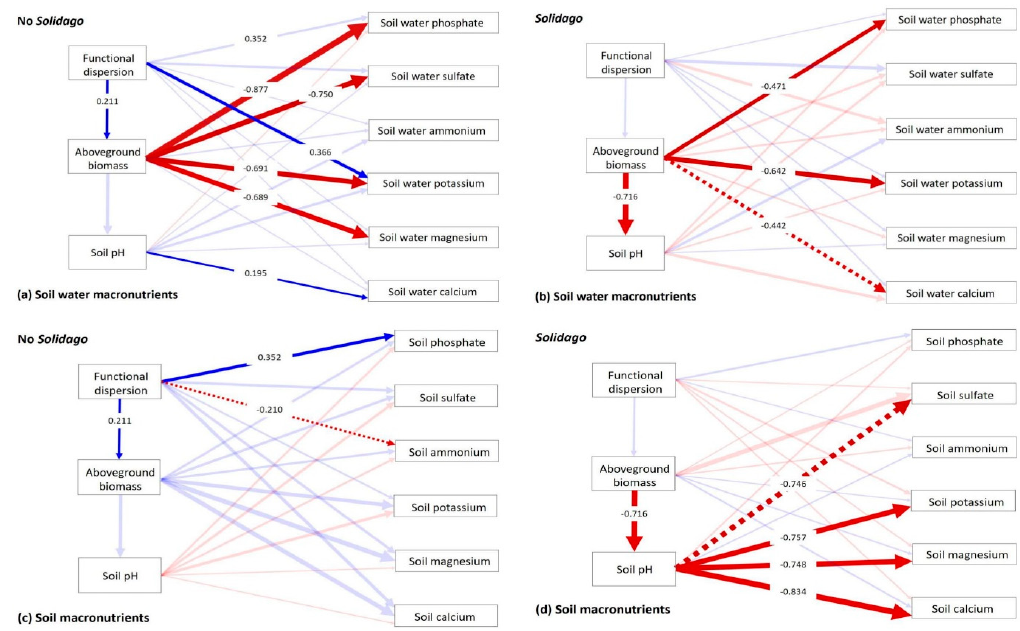
Figure 5. Structural equation model (SEM) for the effects of functional dispersion and Solidago gigantea on the macronutrients in the soil water fraction ( a , b ) and in the soil of the grassland communities ( c , d ). Unidirectional relationships among variables are represented by the arrows, and path coefficients indicate the strength of the correlations [31]. Arrow thickness reflects scaled values of coefficients and solid arrows represent significant effects ( p ≤ 0.05). Blue arrows represent positive and red arrows negative effects. Dotted arrows show marginally significant ( p ≤ 0.1) and transparent arrows non-significant effects ( p > 0.10).